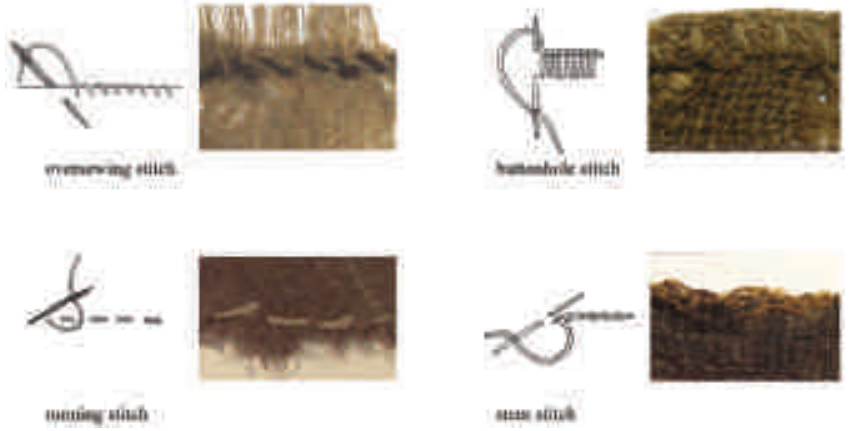
Figure 13 Rectangular building wiht sone foundations at KWH1